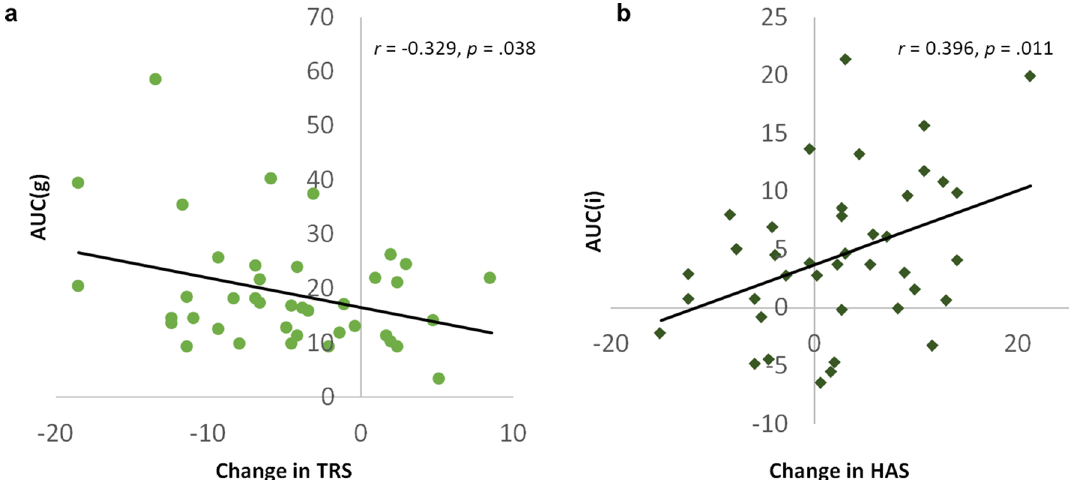
Figure 3. Correlations between cortisol concentration and the change in proportion of time spent in the task- ready state (TRS), high arousal state (HAS) and low arousal state (LAS). ( a ): total area under the cortisol curve (AUCg) is significantly correlated with ∆TRS; ( b ) area under the curve of cortisol increase due to stress (AUCi) is significantly correlated with ∆HAS.